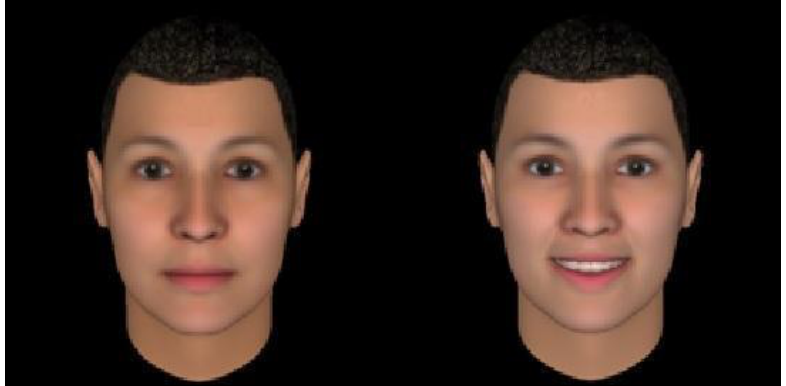
Figure 1 . Neutral-face agent and smiling-face